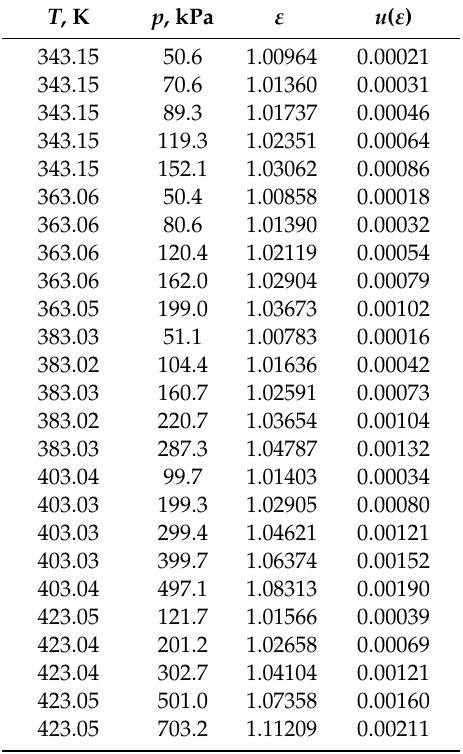
Table 6. Dielectric permittivity data in the vapor phase for HFE-356mmz. T , K